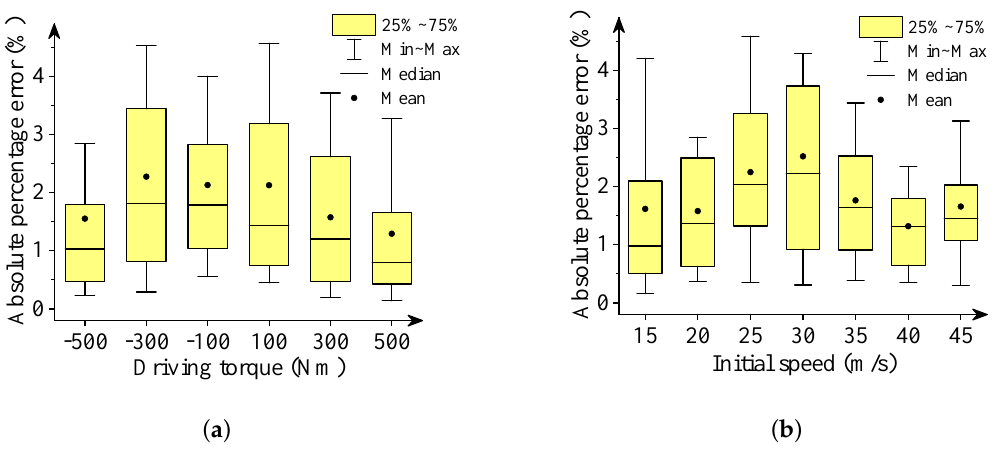
Figure 10. Box plots of absolute percentage error: yaw angle. ( a ) Driving torque; ( b ) Initial speed. Two conclusions can be drawn based on the absolute percentage error analysis